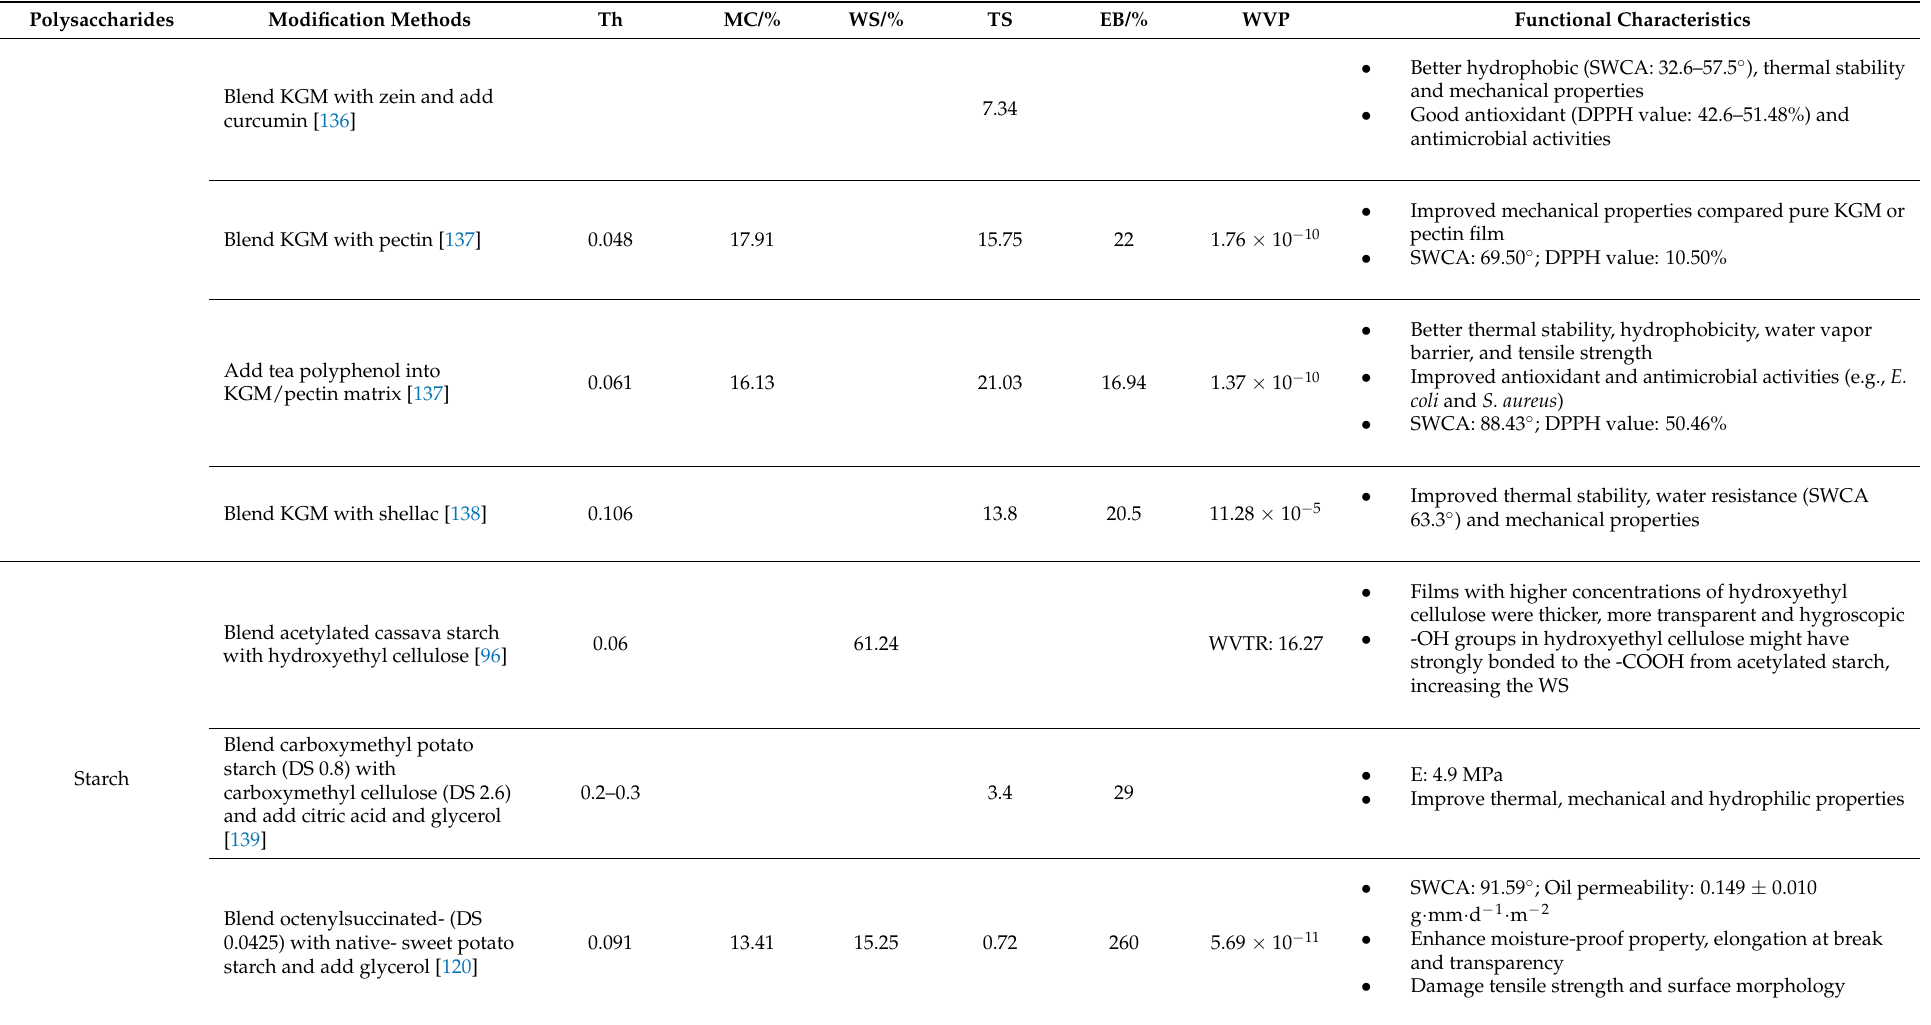
Polysaccharides Functional